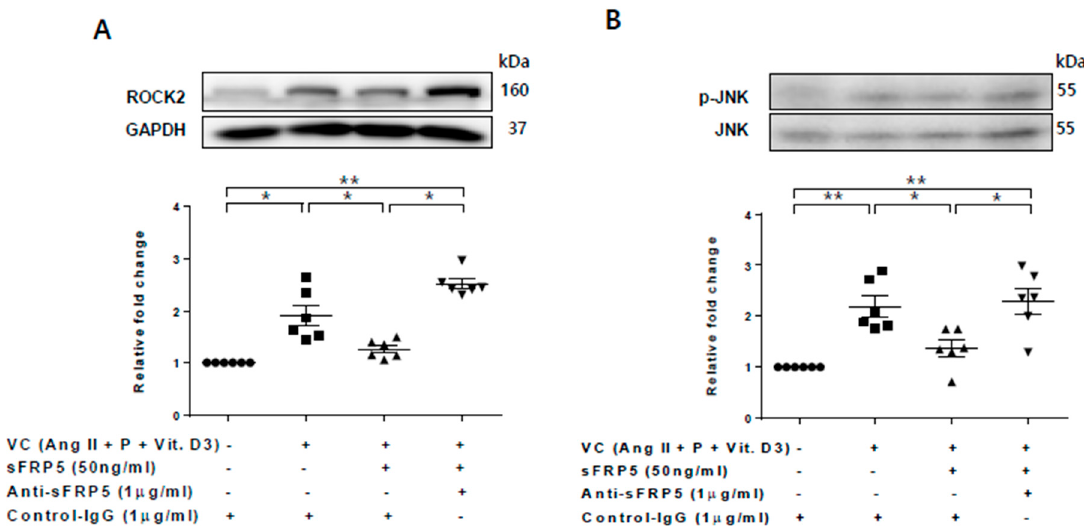
Figure 4. The protective e ff ect of secreted frizzled-related protein 5 (sFRP5) against vascular smooth muscle cell (VSMC) di ff erentiation was mediated by the inhibition of noncanonical ( β -catenin–independent) Wnt signaling. VSMCs were cultured with vascular calcification (VC) induction medium in the presence or absence of sFRP5. Six replicates per condition were performed. The protein expressions of ROCK-2 and total and phosphorylated JNK were determined by Western blotting. ( A ) Culture in VC induction medium induced an increase in ROCK-2 expression, and treatment with sFRP5 led to a decrease in ROCK-2 expression. The addition of anti-sFRP5 restored the expression of ROCK-2; ( B ) Culture in VC induction medium increased JNK phosphorylation. Treatment with sFRP5 led to decreased JNK phosphorylation, and neutralization with anti-sFRP5 reversed this e ff ect. Data are expressed as means ± standard errors of the means from six independent experiments. * p < 0.05, ** p < 0.01.